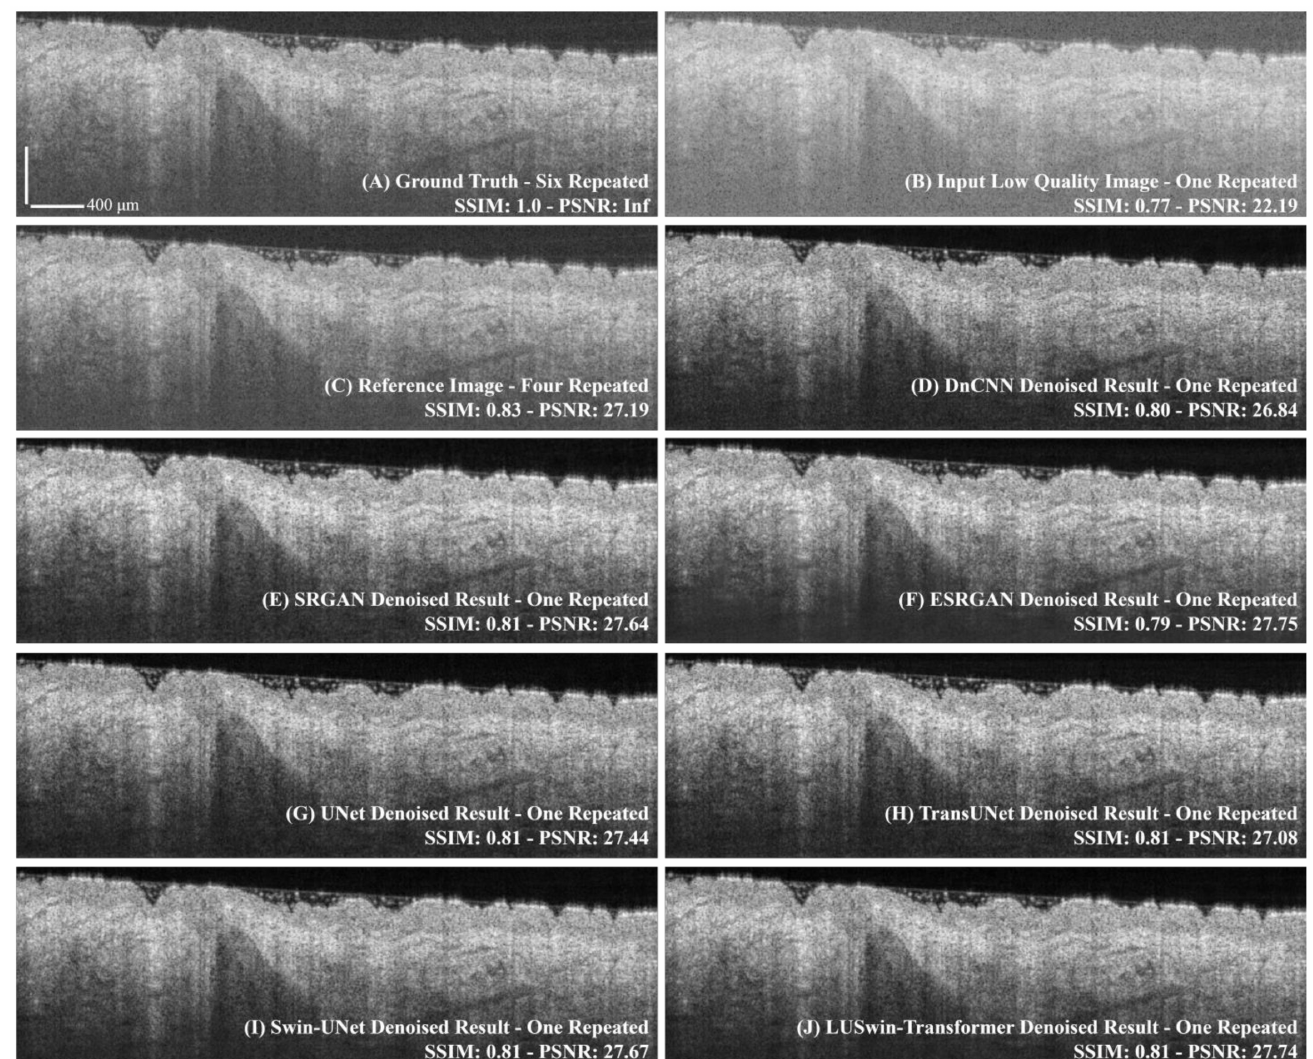
Figure A2. The visual comparison between the different methods. The image is selected from participant #005, representing the neural network performance on the neck. ( A ) High-quality ground-truth image with six-repeated scans. ( B ) Low-quality input image with one-repeated scan. ( C ) High-quality reference image with four-repeated scans. ( D – J ) are neural networks denoised results from ( D ) DnCNN, ( E ) SRGAN, ( F ) ESRGAN, ( G ) UNet, ( H ) TransUNet, ( I ) Swin-UNet, and ( J ) LUSwin transformer. The white label is scale bar with 400 µ